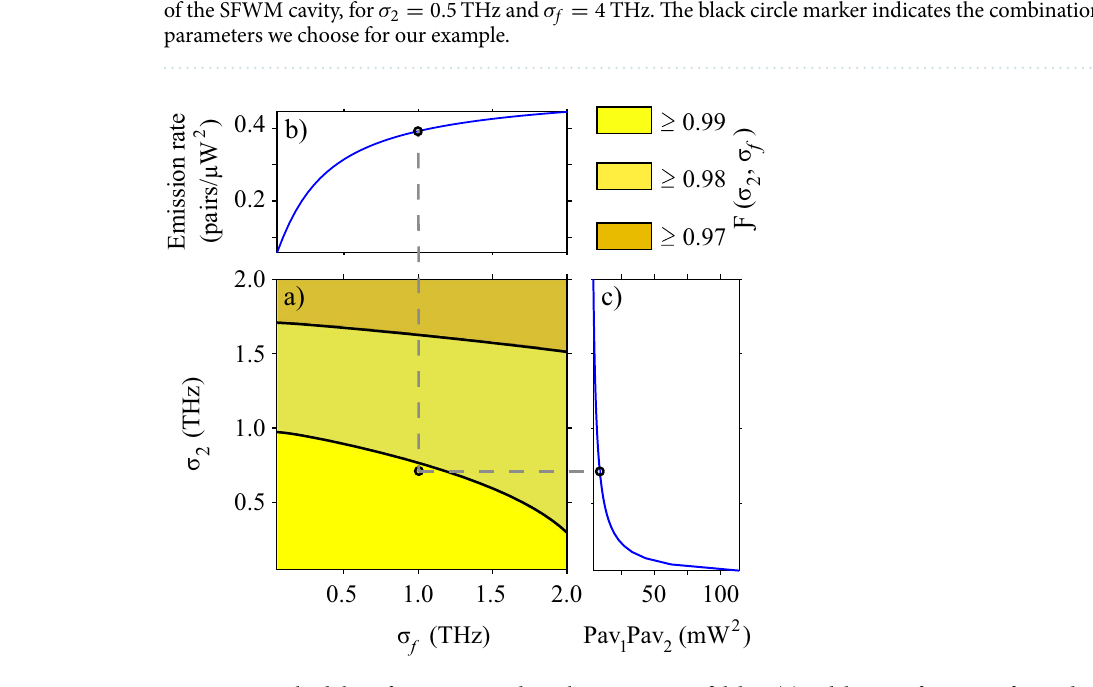
Figure 6. Methodology for increasing the qubit preparation fidelity. ( a ) Fidelity as a function of σ 2 and σ f , while fixing the remaining parameters at the values corresponding to the black circle marker in Fig. 5. ( b ) The photon-pair emission rate per pump-power squared in terms of σ f . ( c ) Minimum product of the average powers of the two pump fields required for a complete frequency conversion in terms of σ 2 . The black circle markers correspond to the choice for our